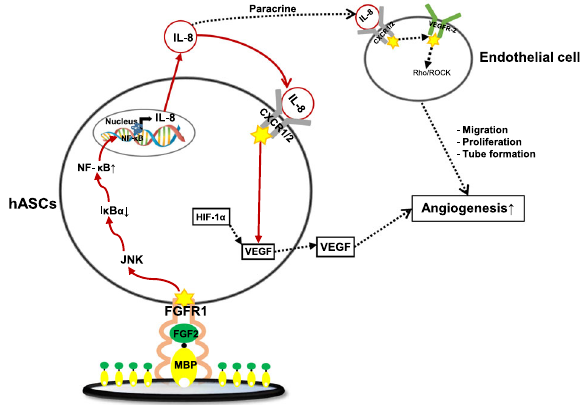
Fig. 10 Schematic model of FECS-Ad mechanism of action for therapeutic angiogenesis. Proposed model for IL-8 production in FECS-Ad and its therapeutic potential in ischemic diseases. MBP- FGF2 binds to the FGFR1 of hASCs, activates JNK-NF- κ B cascade to produce IL-8. IL-8 secreted from FECS-Ad not only acts on hASCs in an autocrine manner to induce VEGF secretion, but also contributes to the formation of tubular structure of endothelial cells. The red solid line is de fi ned in this study, and the dotted line is already known through reference literature 16,37